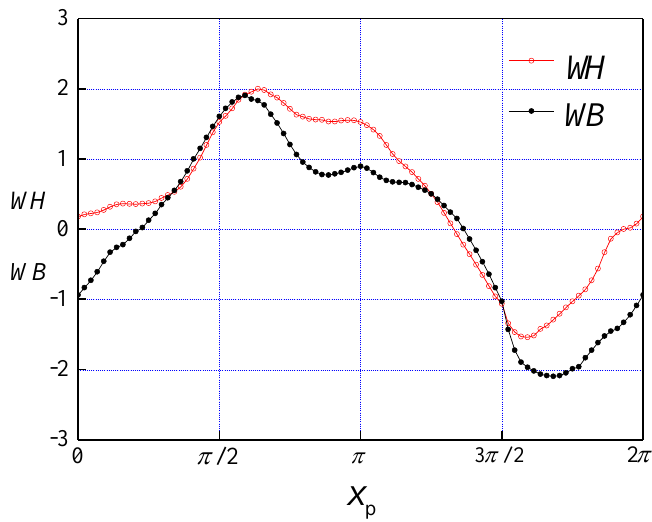
Figure 3. Complete characteristic curve of the pumps.